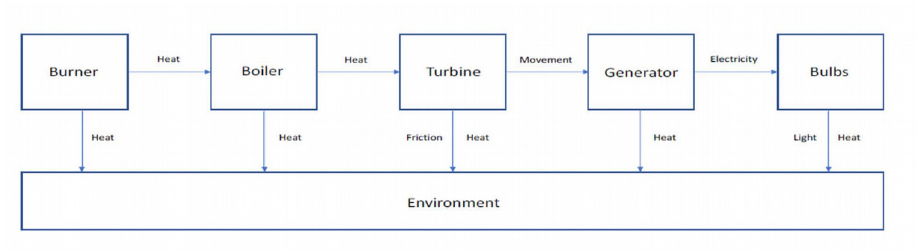
Figure 4. Schematic representation of the energy chain corresponding to the energy description of a TPP